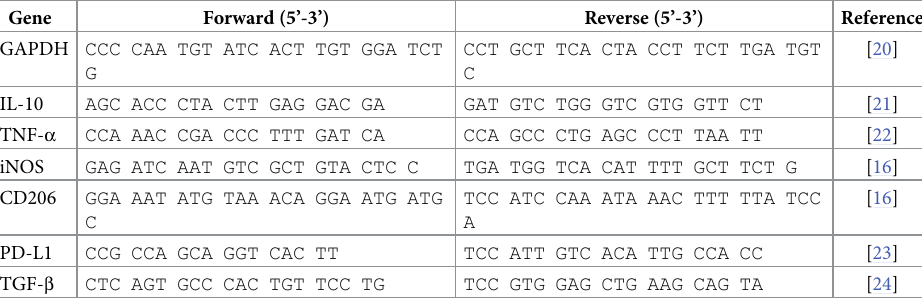
Table 2. Sequences of canine PCR primers used in this